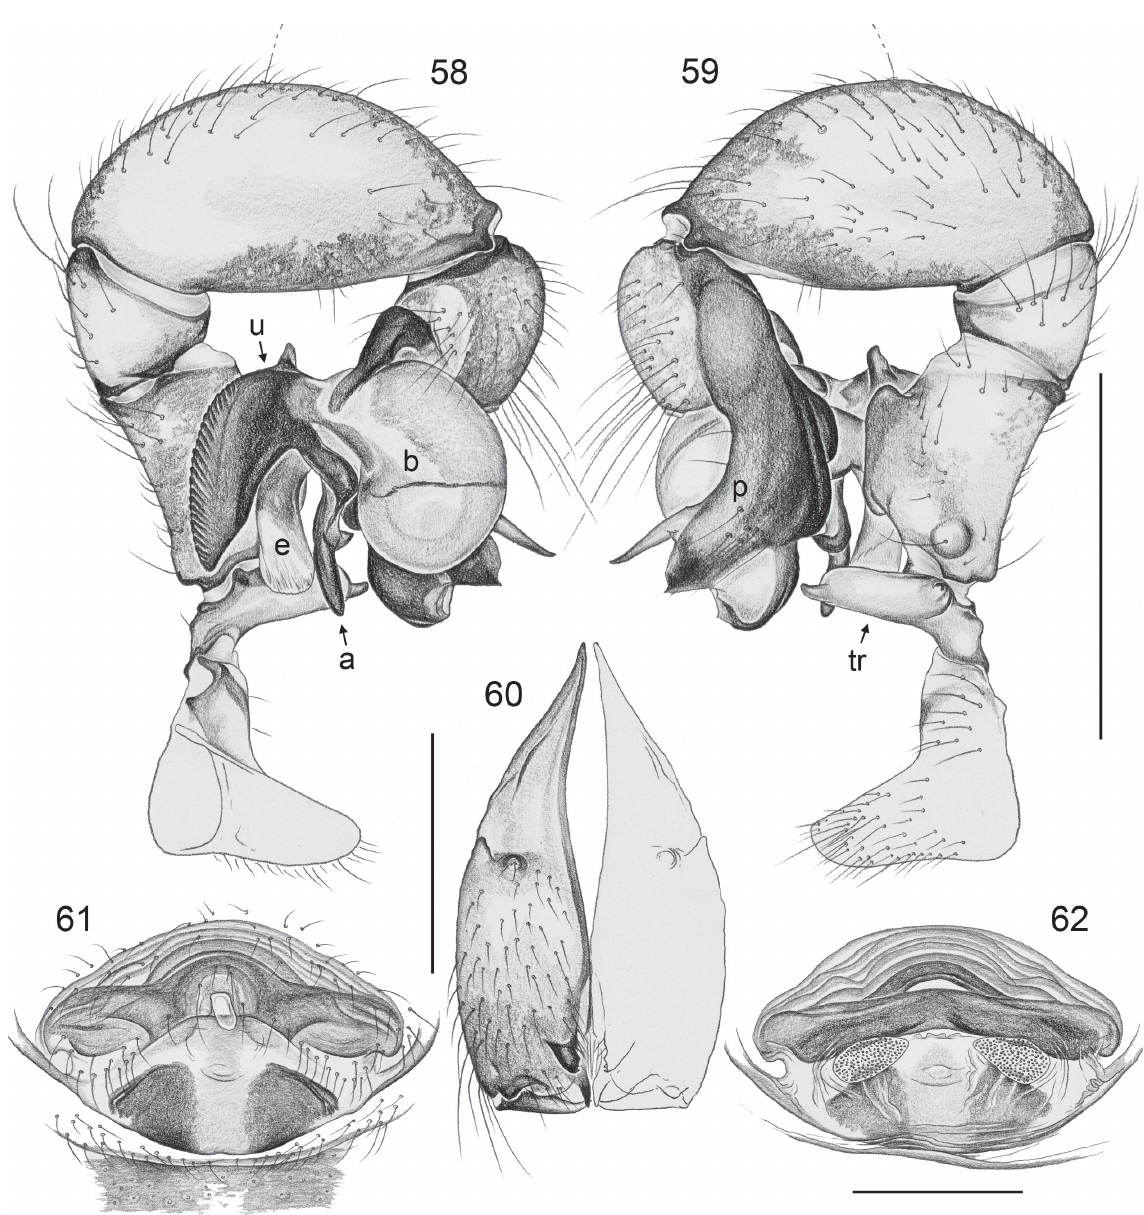
Figs 58–62. Pholcus baguio Huber, sp. nov., ZFMK Ar 15507–08. 58–59 . Left male palp, prolateral and retrolateral views. 60 . Male chelicerae, frontal view. 61–62 . Cleared female genitalia, ventral and dorsal views. Scale lines: 58–59 = 1 mm; 60–62 = 0.5